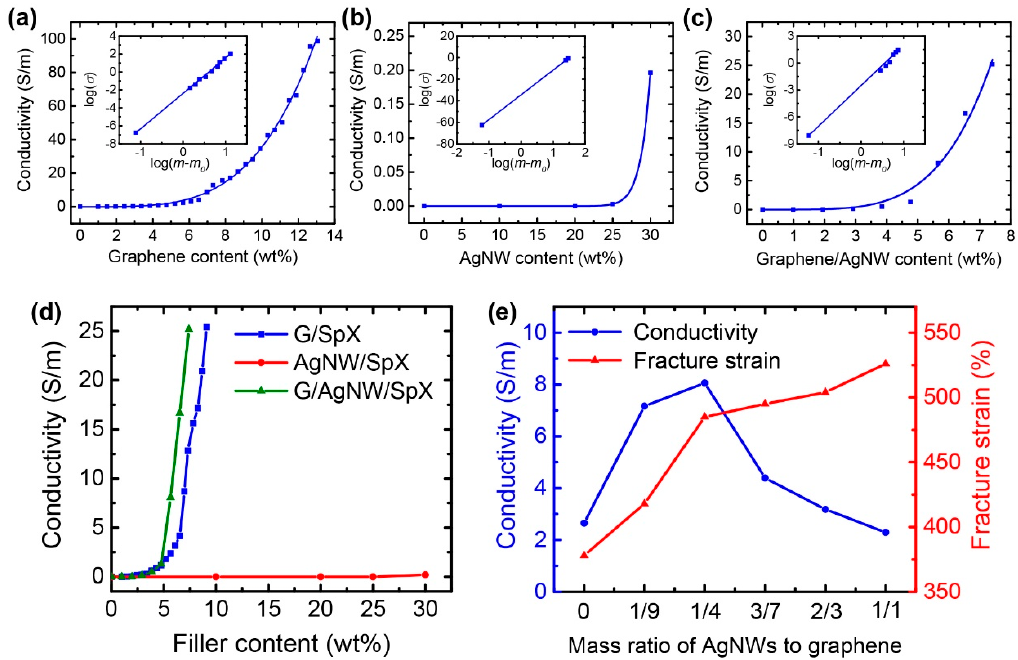
Figure 3. ( a – d ) Electrical conductivity of composite films as a function of filler loading; The insets in ( a – c ) show the log( σ ) versus log( m − m 0 ); The G / AgNW / SpX composite in ( c ) had a mass ratio of AgNWs to graphene of 1 / 4; ( d ) Comparision of the electrical conductivity of composite films; ( e ) Electrical conductivity and fracture strain of the G / AgNW / SpX composite as a function of the mass ratio of AgNWs to graphene, with a total filler concentration of 5.66